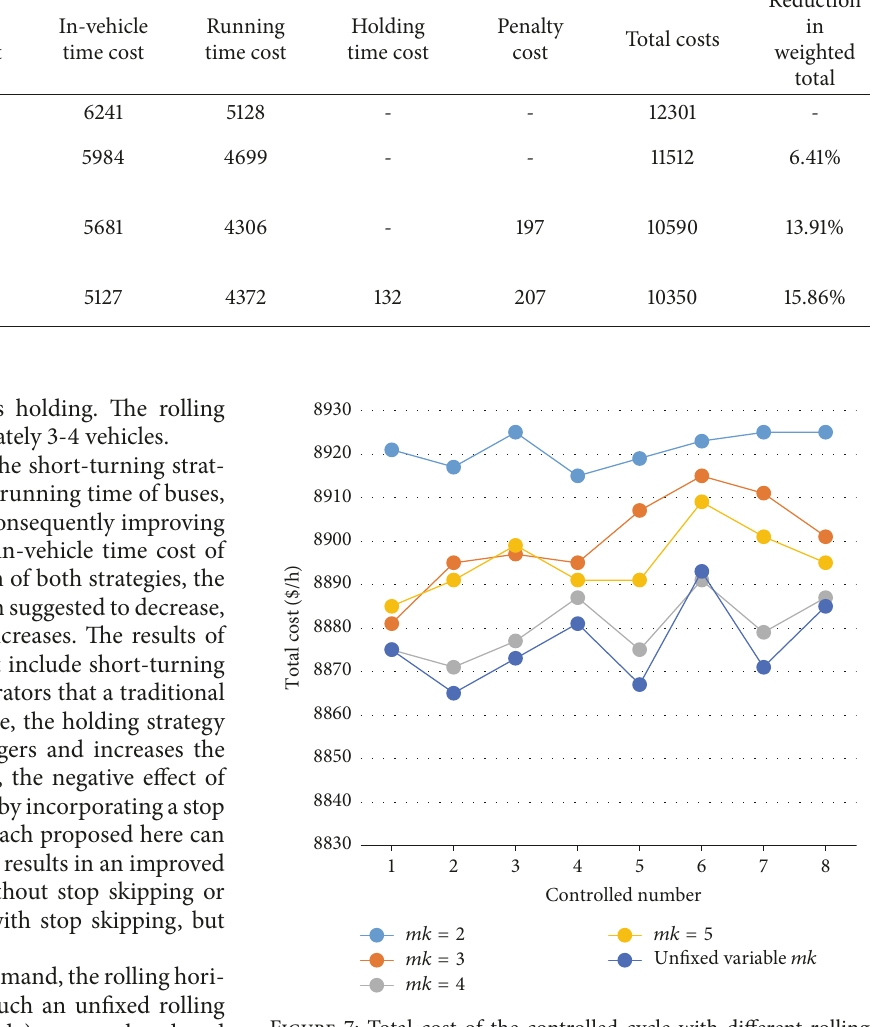
Figure 7: Total cost of the controlled cycle with different rolling